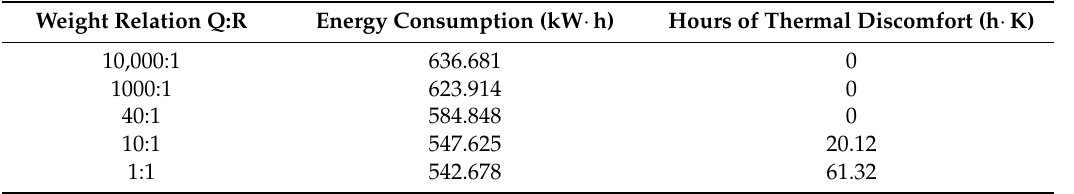
Table 4. Energy consumption in February for different weight